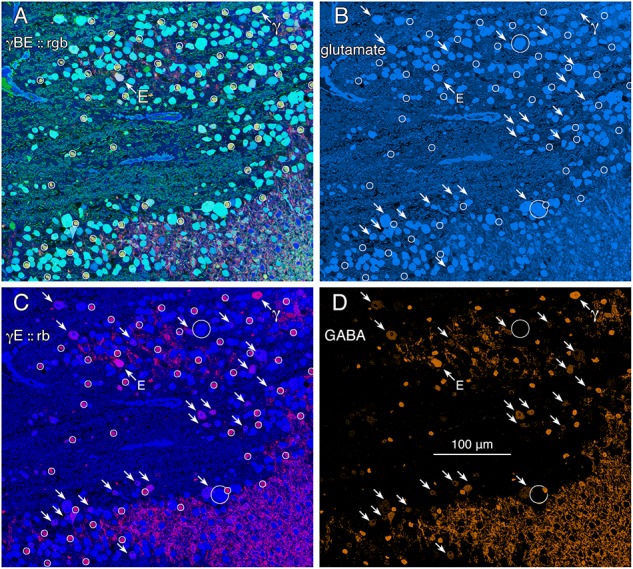
Glutamate and GABA colocalization in the goldfish ganglion cell layer; registered serial 200 nm sections with silver density visualization inverted (with a logical NOT) to an intensity display (Marc et al., 1995). (A) GABA (γ), AGB (B), and glutamate (E) signals assigned to the red (r), green (g), and blue (b) channels, respectively, creating an rgb image reflecting the combined small molecule signature. AGB permeation was activated in vitro with 50 μM kainic acid (KA) in the presence of 10 mM AGB in Hickman’s Teleost saline (Marc et al., 1995). This signature separates ON starburst amacrine cells (small circles) with a yellow signal mixture (high GABA and AGB, representing classic strong starburst amacrine cell KA responses) from cyan ganglion cells (high glutamate and AGB, representing strong ganglion cell responses to KA), light blue ganglion cells (high glutamate, low AGB, representing weak ganglion cell responses to KA), and deep blue spherical terminals of Mb ON cone bipolar cells (surrounded by a polygon), which lack ionotropic glutamate receptors. The northwest arrow labeled with the E symbol indicates a high glutamate content ganglion cell with modest GABA and high AGB signals. The northwest arrow labeled with the γ symbol indicates a low glutamate, high GABA, non-starburst amacrine cell. (B) Glutamate channel, intensity mapped as medium blue for visibility (R = 0, G ≈ 0.5B, B ≈ 0–240). Southeast arrows denote high glutamate ganglion cells that also have significant GABA signals. (C) GABA and glutamate channels mapped as γE :: rb, revealing γ+ ganglion cells as magenta cells. (D) GABA channel mapped as orange for visibility (R ≈ 0–240, G ≈ 0.5R, B = 0), clearly revealing weak GABA signals in a set of high glutamate ganglion cells. Scale, 100 μm.